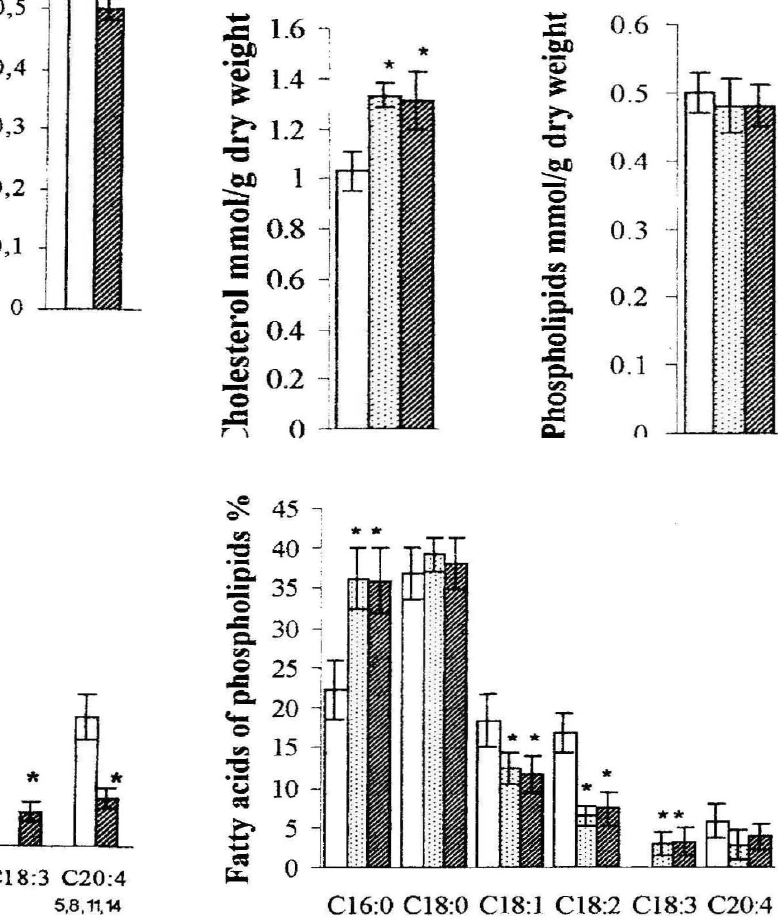
Fig.S . Concentrations (mean ± SO) of cholesterol and phospholipids as well as fatty acid content in percent (mean ± SO) in control samples (open bars) and in sam ples with 4 nmol L-kynurenine/g wet weight (hatched bars). Samples of rat liver tissue homogenate were used to test for phospholipid biosynthesis in vitro. Incubation medium: Krebs-Ringer-phosphate buffer (pH=7.4) con taining 0.3% albumin, fatty acid mixture and glycerol. Samples were incubated twice for 4 h at 37°C; the dif ference is statistically significant (P < 0.00 I).